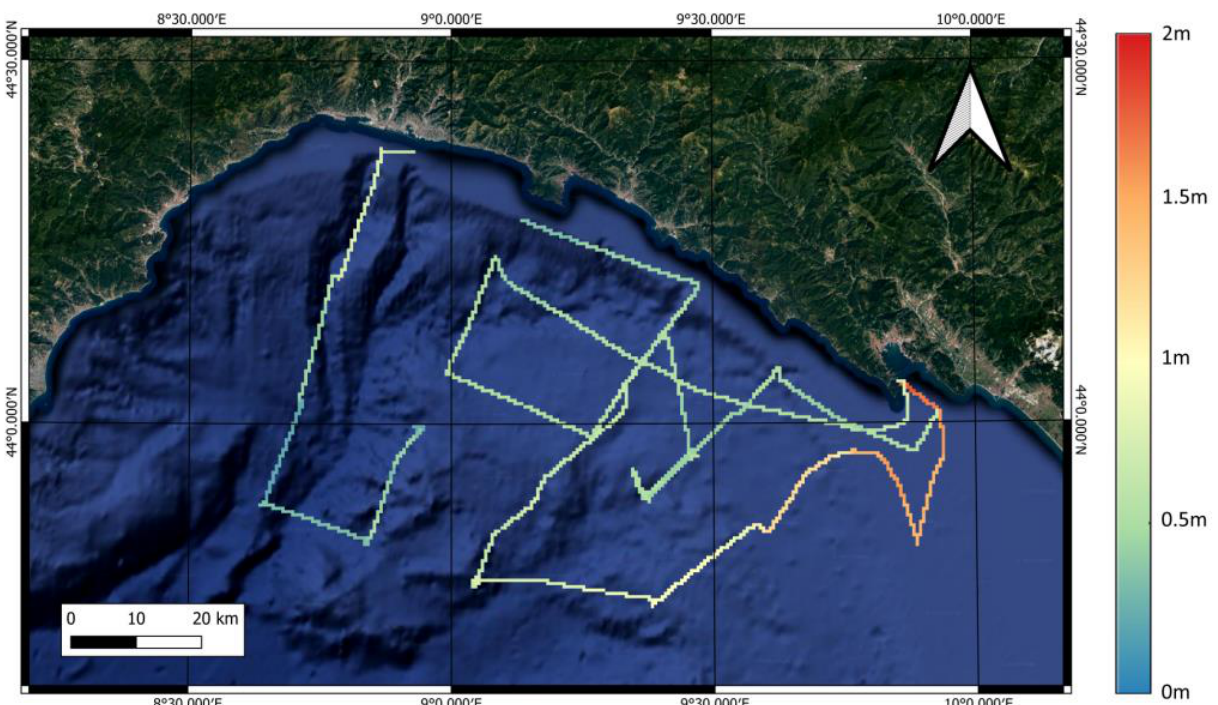
Figure 10. Wave height at each position selected at the time of measurements from W1-M3A data set.